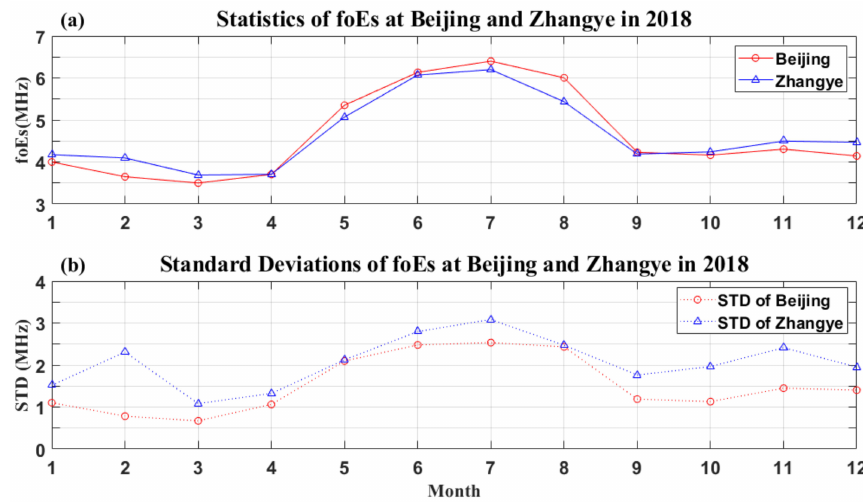
Figure 7. Seasonal changes in mean values ( a ) and standard deviations ( b ) of foEs in the Es layer at Beijing and Zhangye stations.